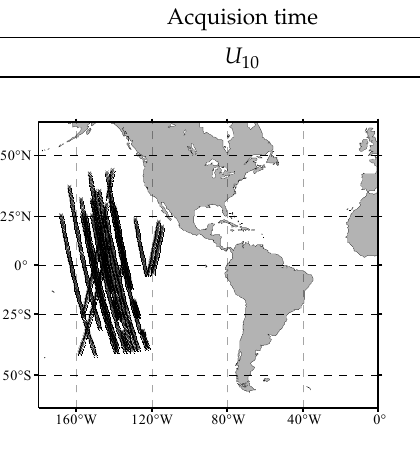
Figure 1. Map of collected GF-3 SAR wave mode imagery.